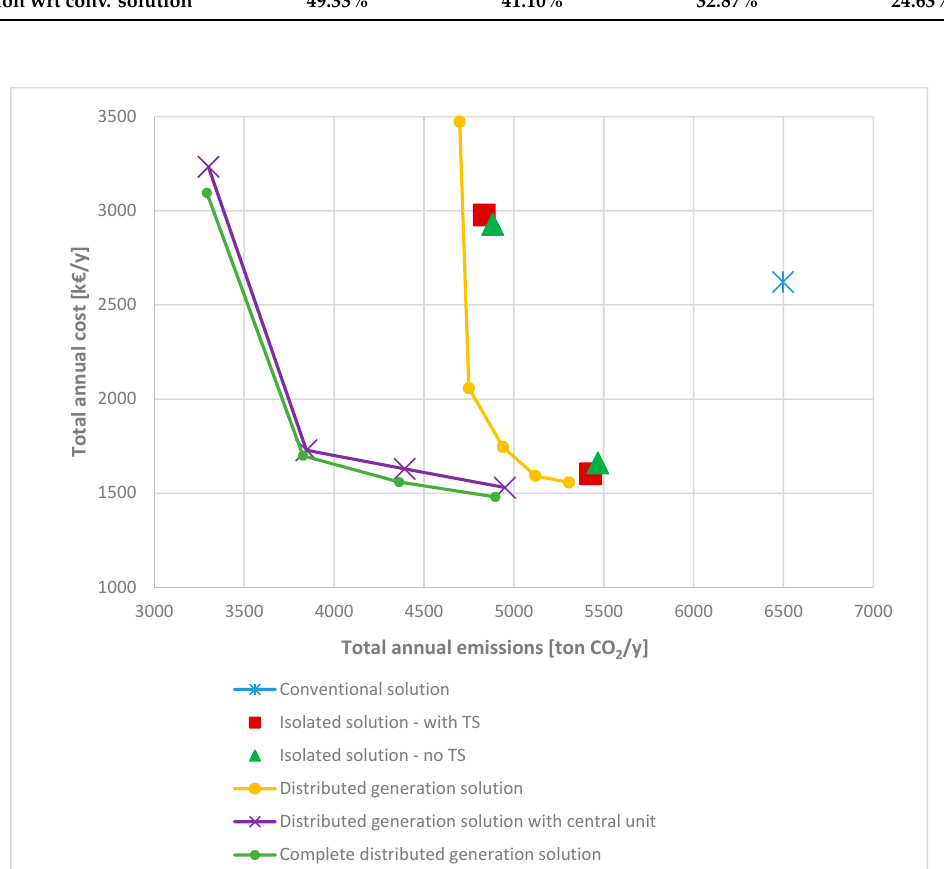
Figure 15. Pareto front of the optimal complete distributed generation solutions.